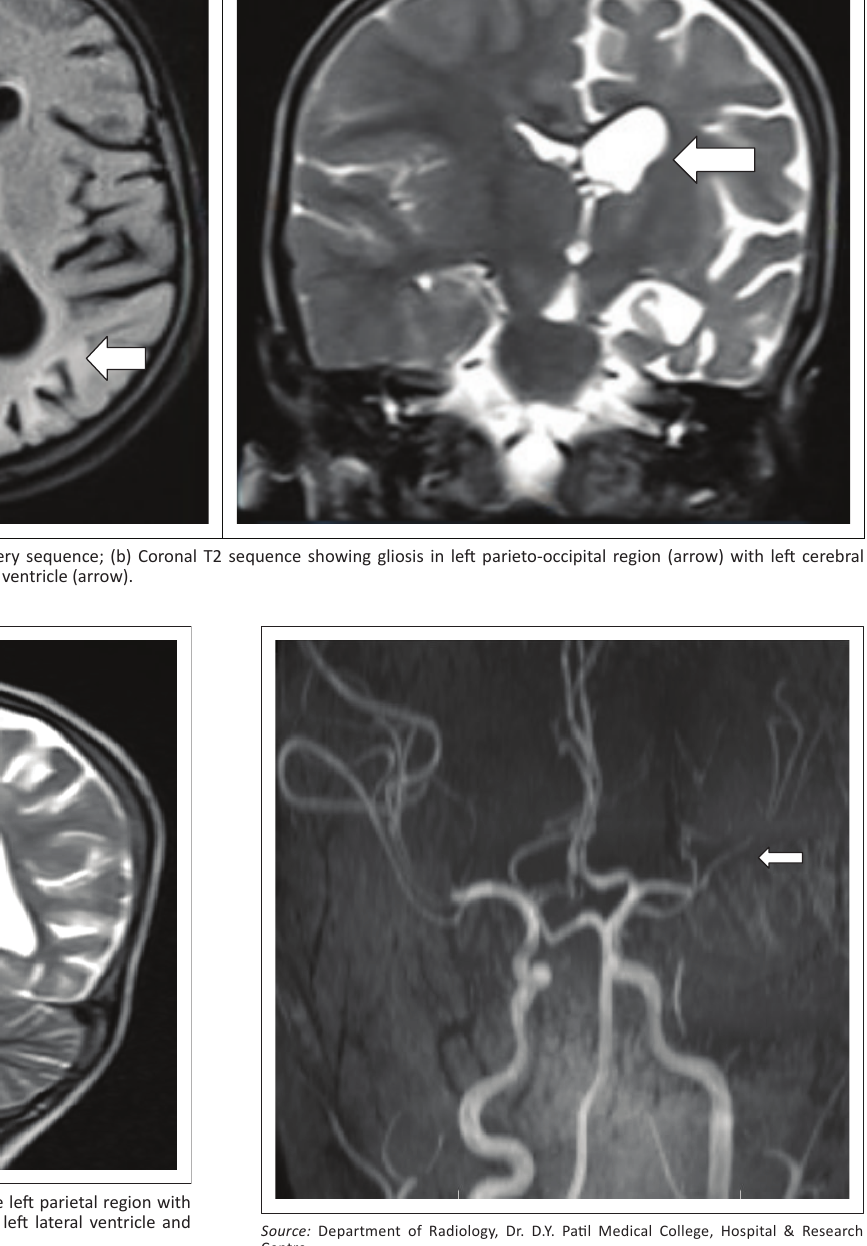
FIGURE 5: Magnetic resonance angiography of the brain showing attenuation and reduced signal intensity of M2 and M3 segments of left MCA